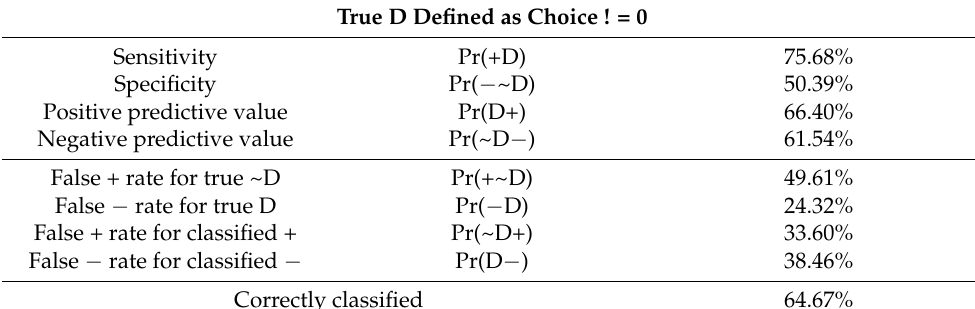
Table A11. Test of reliability of the logit model in Table 2 (dependent variable: choosing informality).